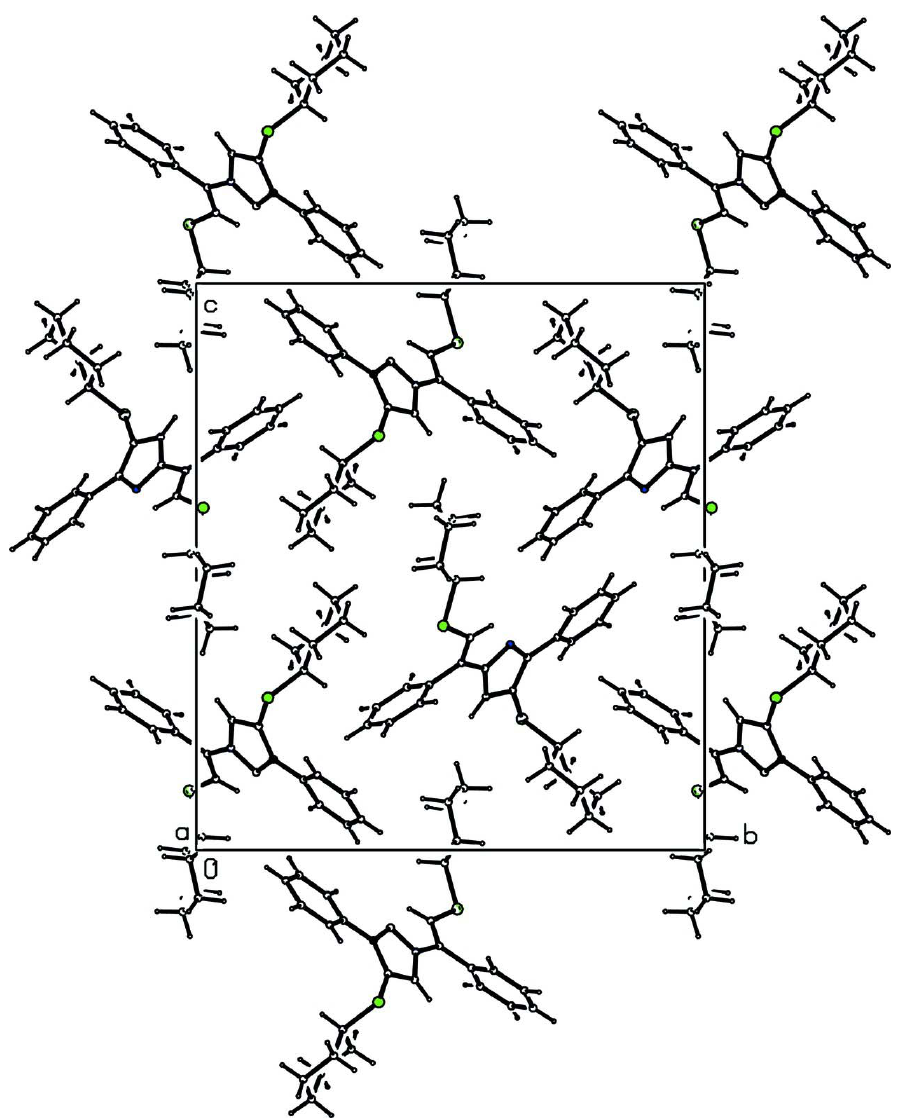
Figure 2 The packing of the molecules in the unit cell viewed down the a axis. 4-(Cyclohexylsulfanyl)-1-[( E )-2-(cyclohexylsulfanyl)-1-phenylethenyl]-3-phenyl-1 H -pyrazole Crystal